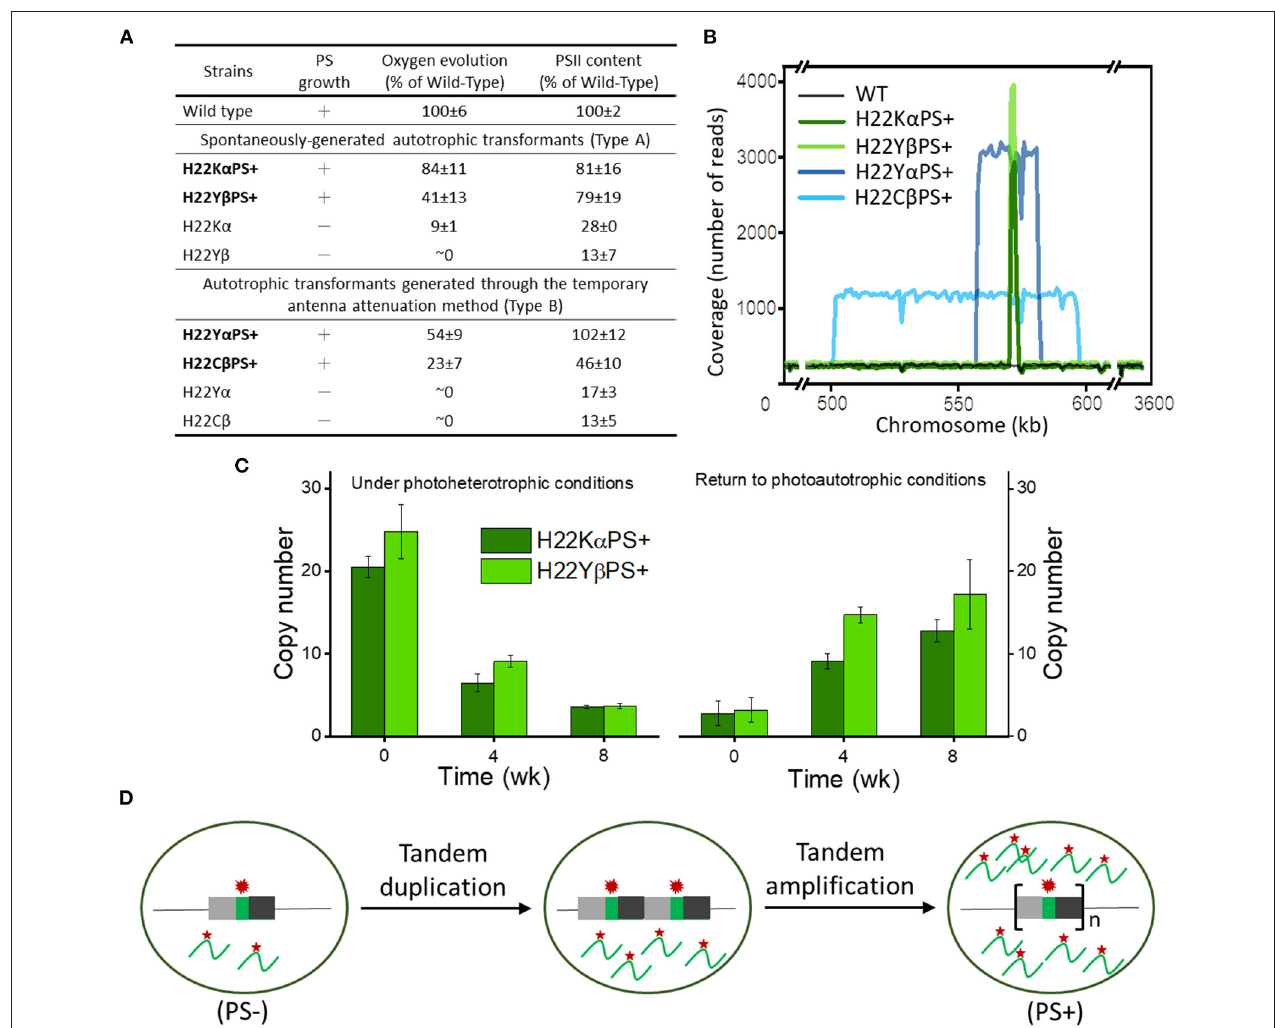
FIGURE 1 | Photosynthetic growth and genetic properties of cytochrome b 559 (Cyt b 559 ) autotrophic transformants. (A) General properties of 2 distinct types of Cyt b 559 autotrophic transformants. (B) Copy number, size, and location of repeat elements in autotrophic transformant cells. (C) Quantitative droplet digital polymerase chain reaction (PCR) analysis of the time course of copy number variation of psbEFLJ in autotrophic transformants grown under photoheterotrophic conditions and then returned to photoautotrophic conditions. (D) Model for tandem gene amplification of chromosome segments containing the psbEFLJ operon (asterisk) in autotrophic transformants recovering their photosynthetic growth [Reprinted with permission from Chiu et al. (2022), open access article by the New Phytologist